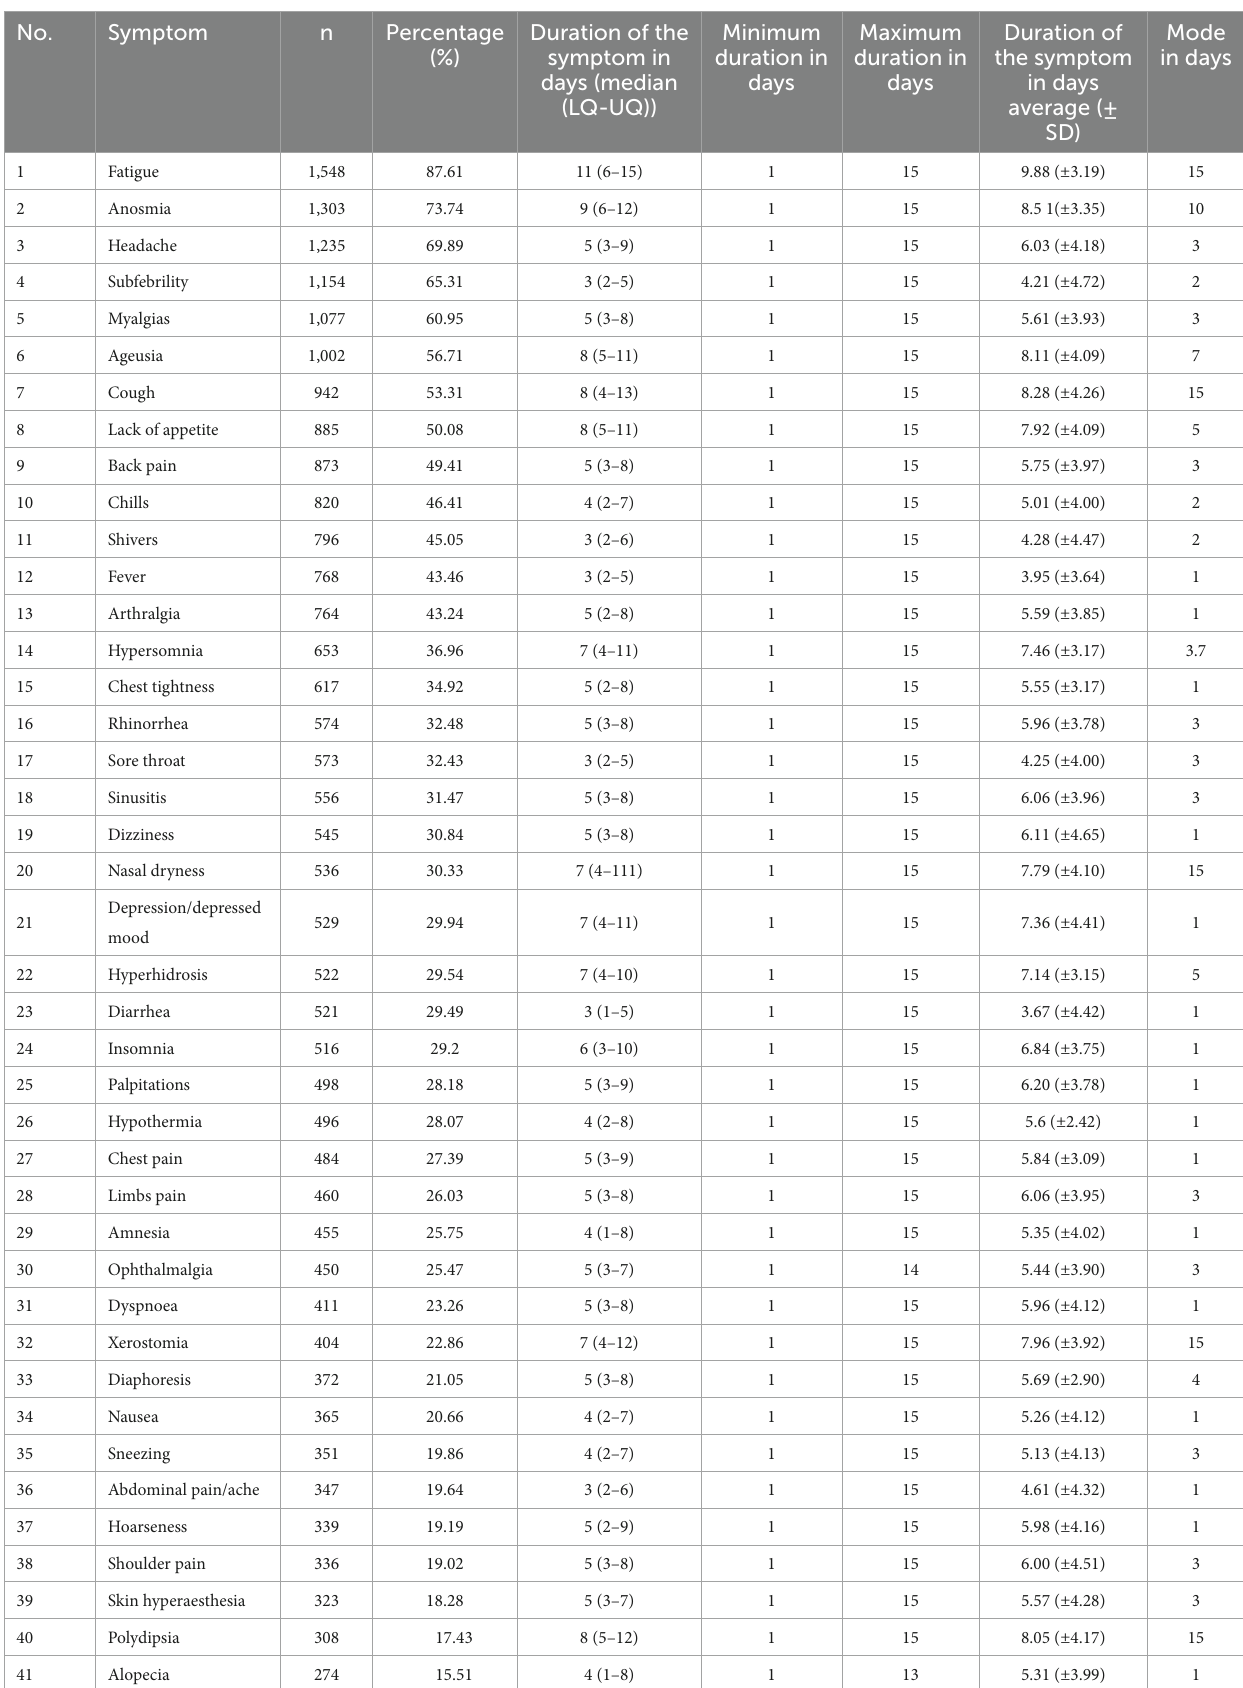
TABLE 3 Prevalence of symptoms and their duration in studied population ( N = 2,408).